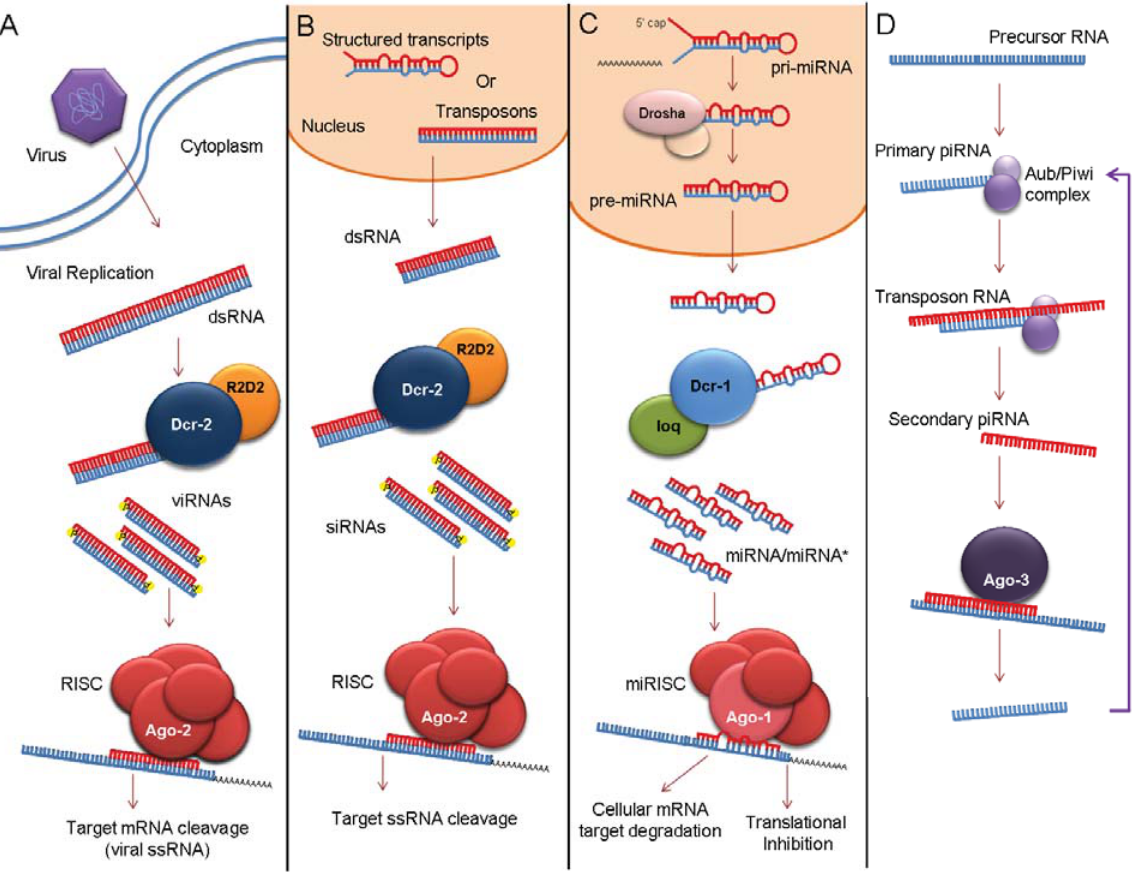
Figure 1. Schematic representation of the exogenous siRNA ( A ), endogenous siRNA ( B ), microRNA (miRNA) ( C ), and PIWI-interacting RNA (piRNA) ( D ) pathways present in insects; presented for Drosophila melanogaster . dsRNA, double stranded RNA; Dcr, Dicer; RISC, RNA-induced silencing complex; Ago, Argonaut; viRNA, viral specific small interfering RNA; siRNA, small interfering RNA; loq, loquacious; ssRNA, single stranded